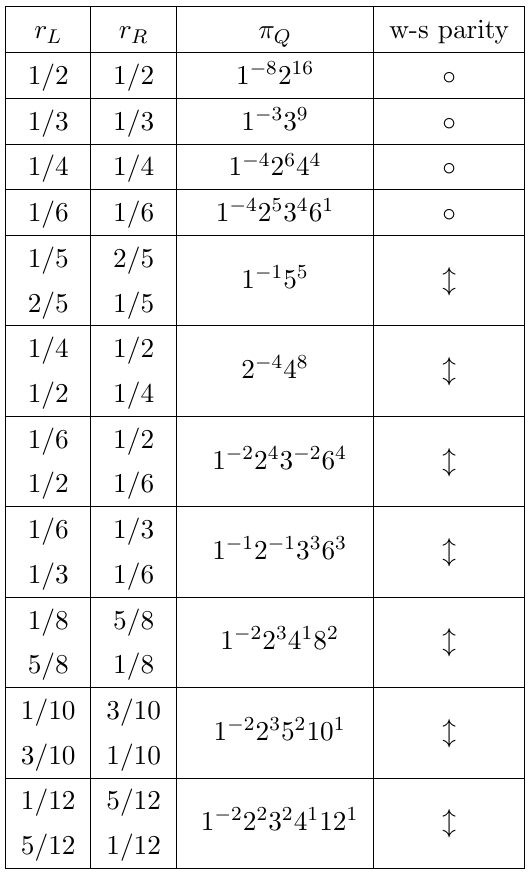
Table 1. Frame shapes corresponding to quantum symmetries of torus orbifolds. The twining genera can be obtained by applying formulae (6.1) and (6.2) . The last column reports whether world sheet parity (cid:12)xes the twining genus for a quantum symmetry (symbol (cid:14) ) or if it relates two of them (symbol l